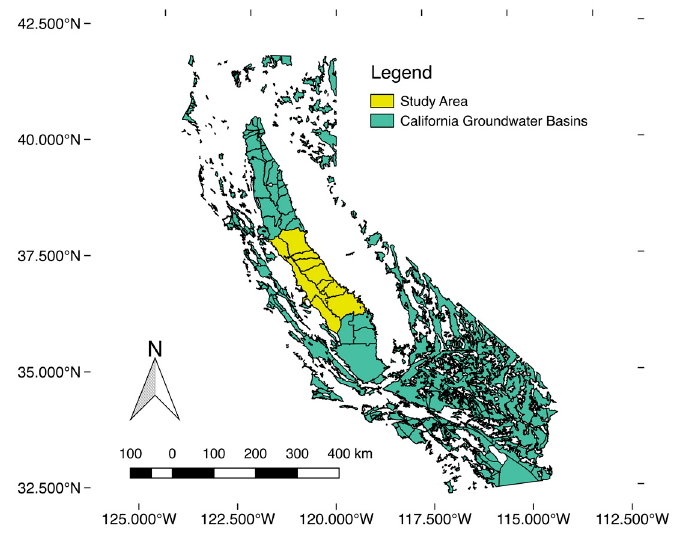
Figure 1. Map of California groundwater basins [61]. The study region, the San Joaquin Valley, is highlighted in yellow.